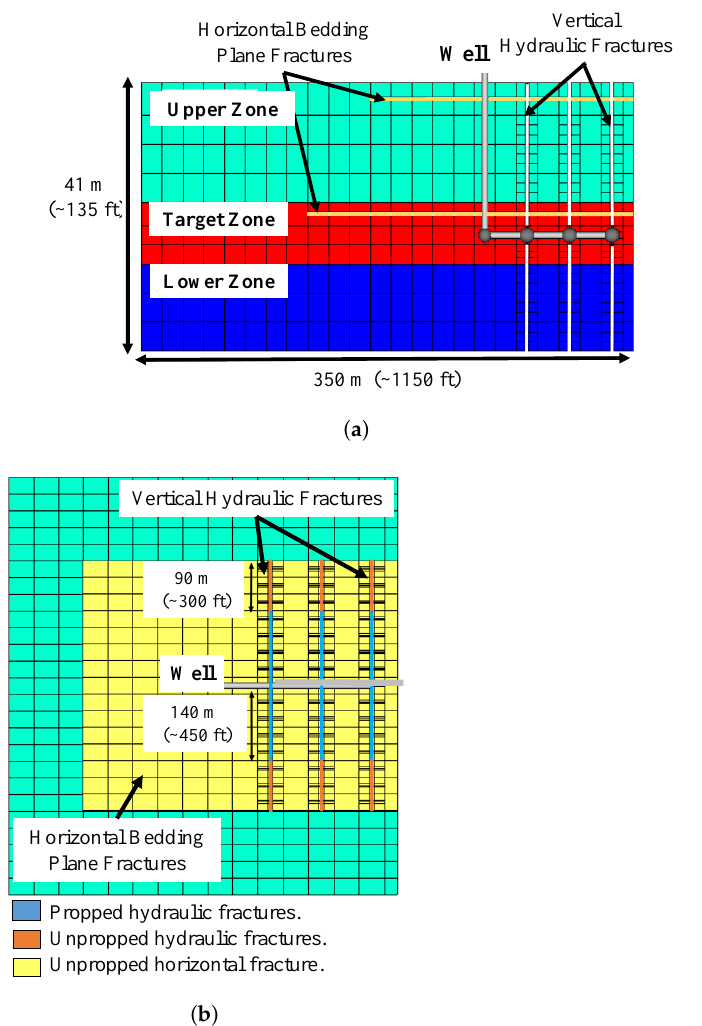
Figure 8. Vertical hydraulic fractures with horizontal bedding plane fractures. ( a ) Cross-view of the model along the wellbore and ( b ) map view of the